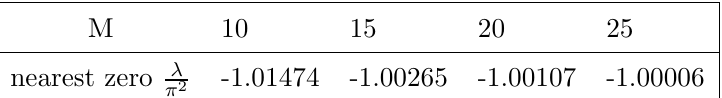
Table 3 . Smallest singularities of (cid:1) w 3 as determined from its diagonal Pad(cid:19)e [ M=M ] approximants. See the text for more details.